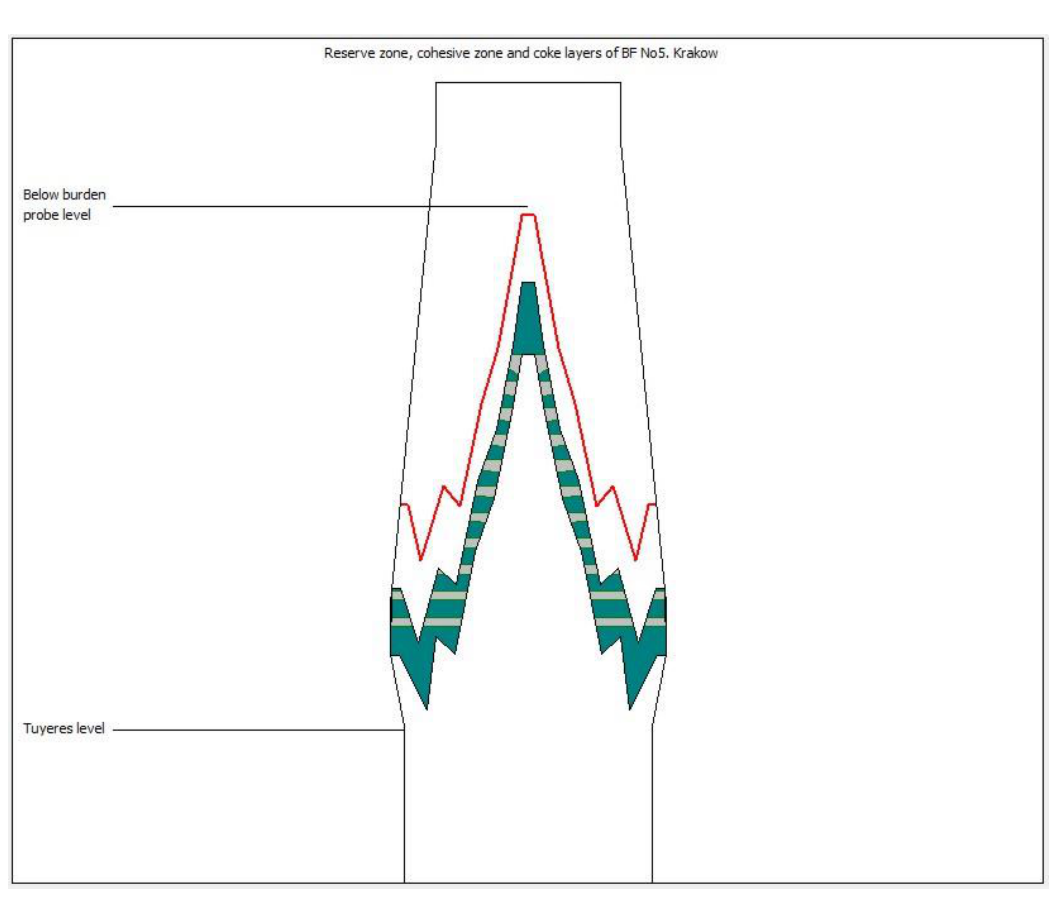
Figure 7. An example of cohesive zone geometry and coke layers situation.